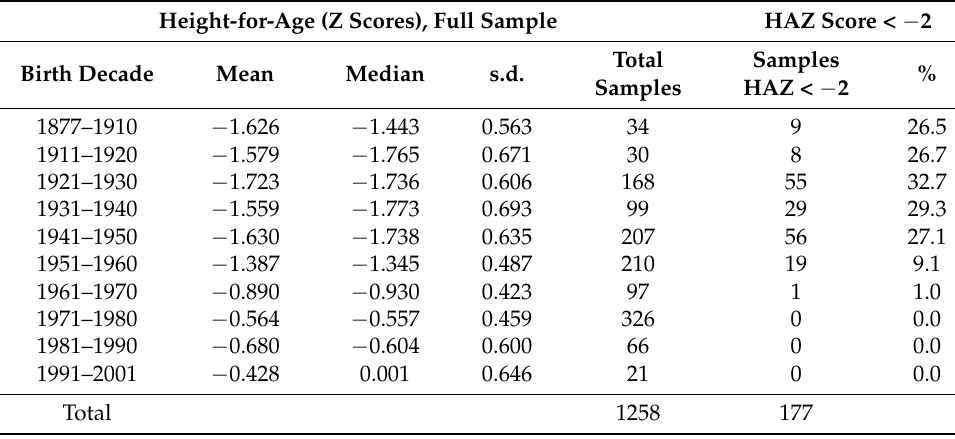
Table 2. Descriptive statistics of samples, by birth decades.